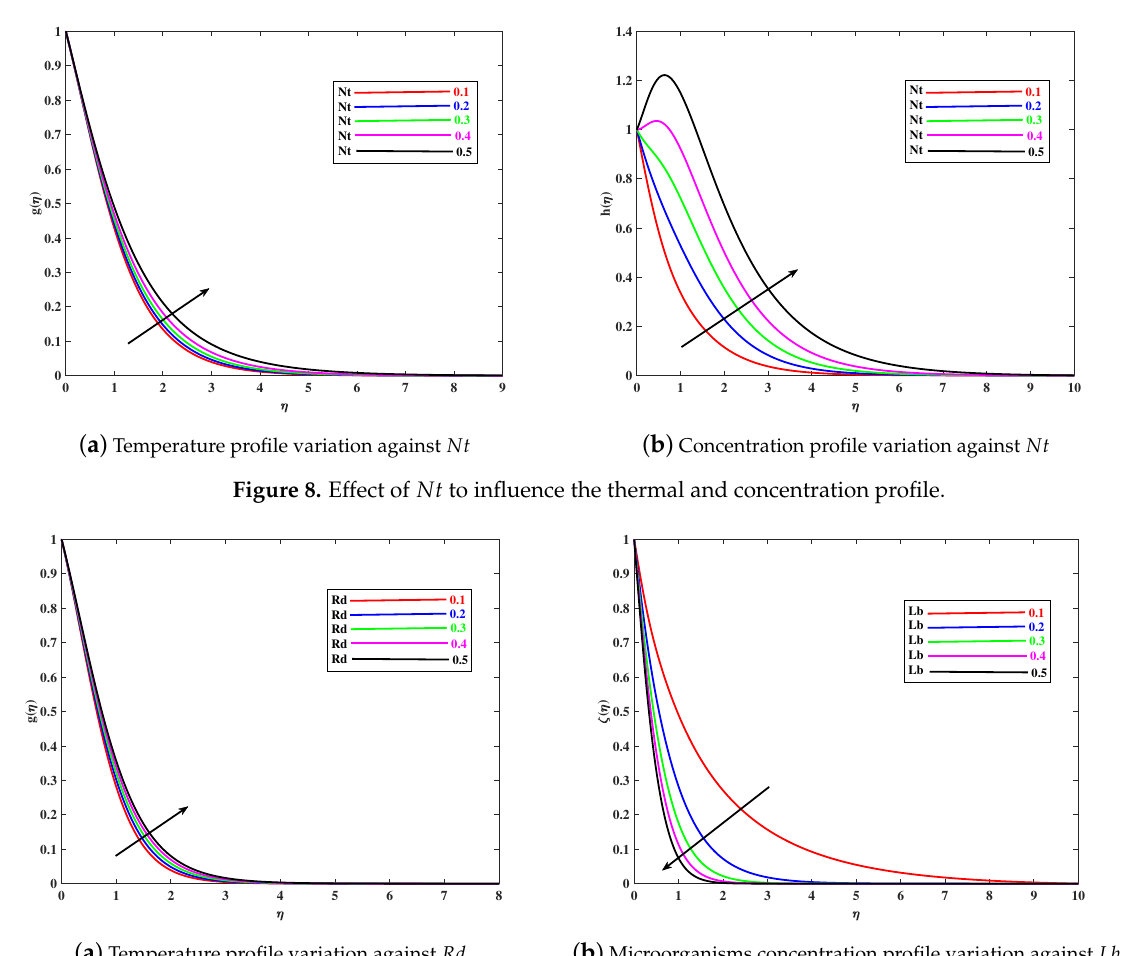
Figure 9. Effect of Rd and Lb to influence the concentration and bioconvection